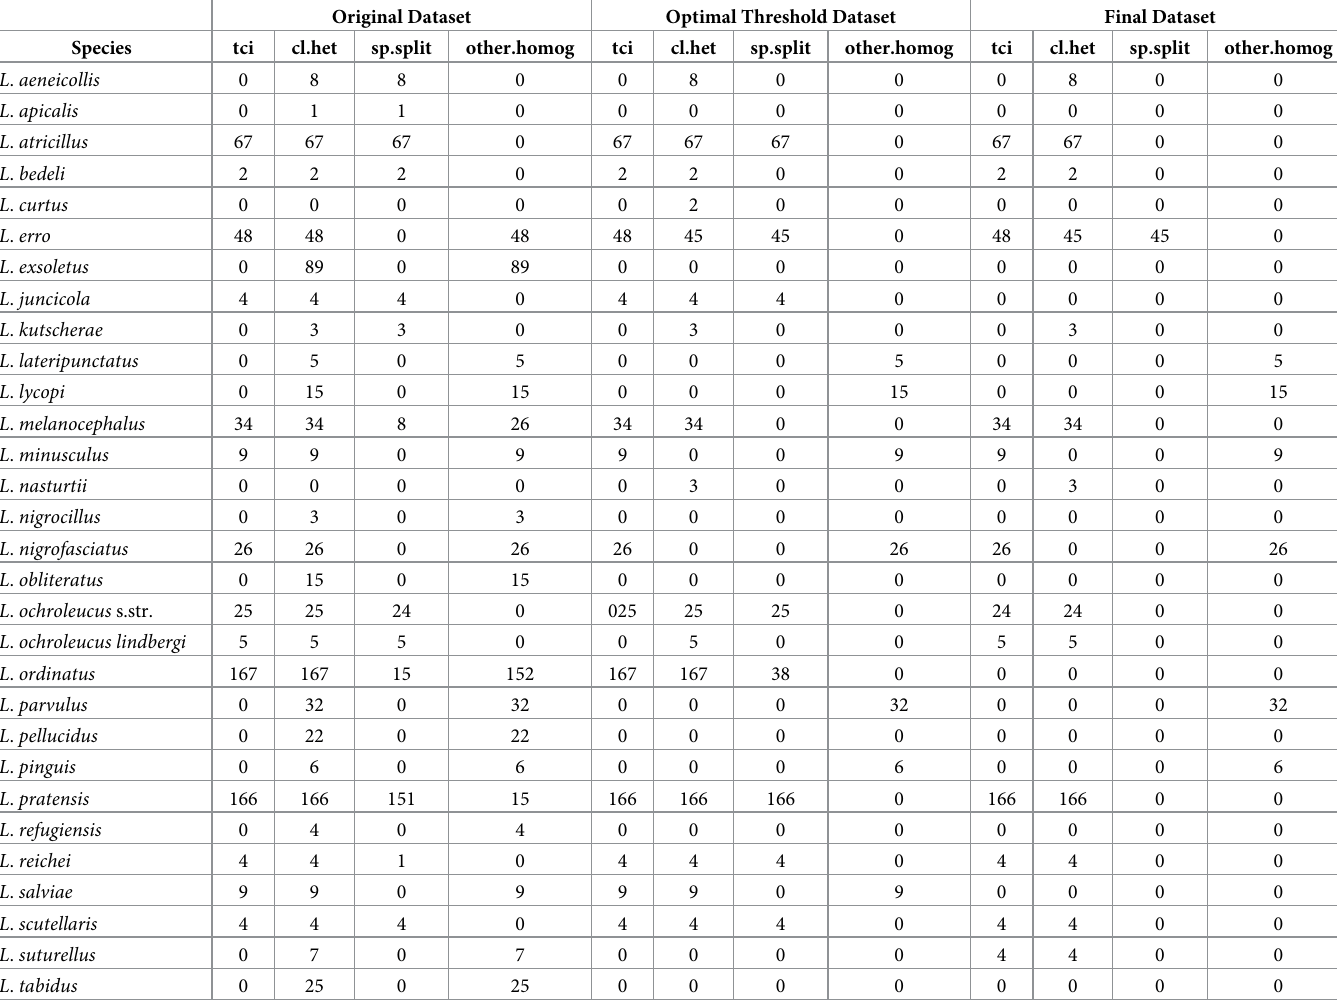
Table 2. Results of the TaxCI analyses. Taxonomic inconsistency for each species are reported as the number of: individuals of a given species not grouped as monophy- lum (tci), individuals of heterogeneous distance-based cluster (cl.het), individuals of a species found in more than one cluster (sp.split) and all individuals of a species in a homogeneous cluster with members in at least one other homogeneous